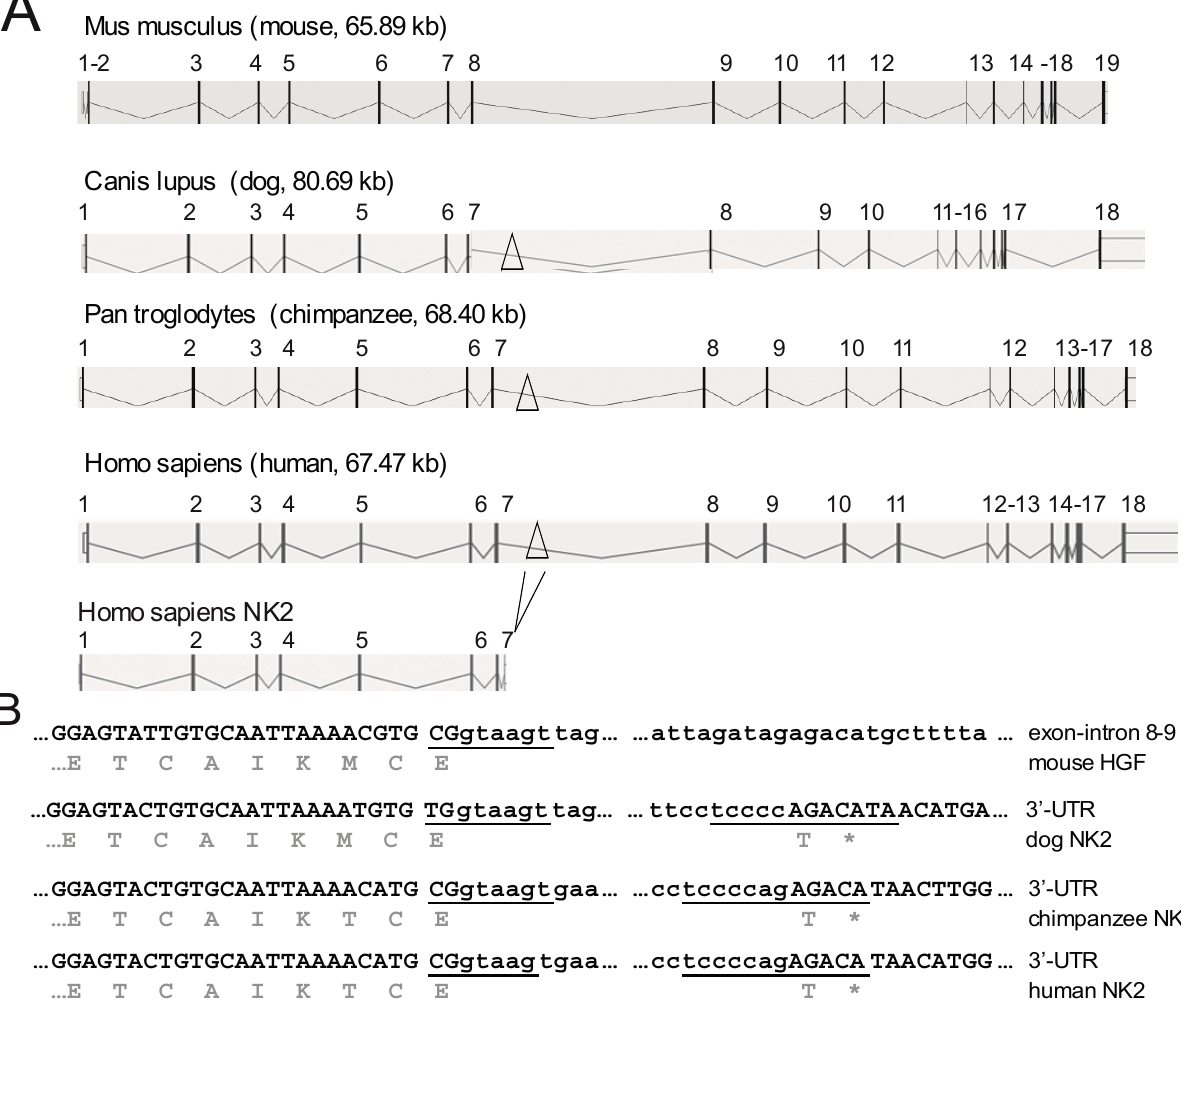
Figure 1. Generation of the NK2 message. ( A ) A schematic comparison of hepatocyte growth factor ( HGF ) genes. Bars and numbers indicate exons. The alternative exon used for NK2 splicing is indicated by a triangle at the corresponding introns. The murine intron does not contain this alternative exon; ( B ) The exon (capital letters)–intron (small letters) boundary sequences for NK2 splicing. Predicted splice donor and acceptor sites are underlined. The murine sequence lacks characteristics commonly found in splice acceptor sites. The carboxy-terminal amino acids of NK2 and the stop codon ( * ) are shown below the coding